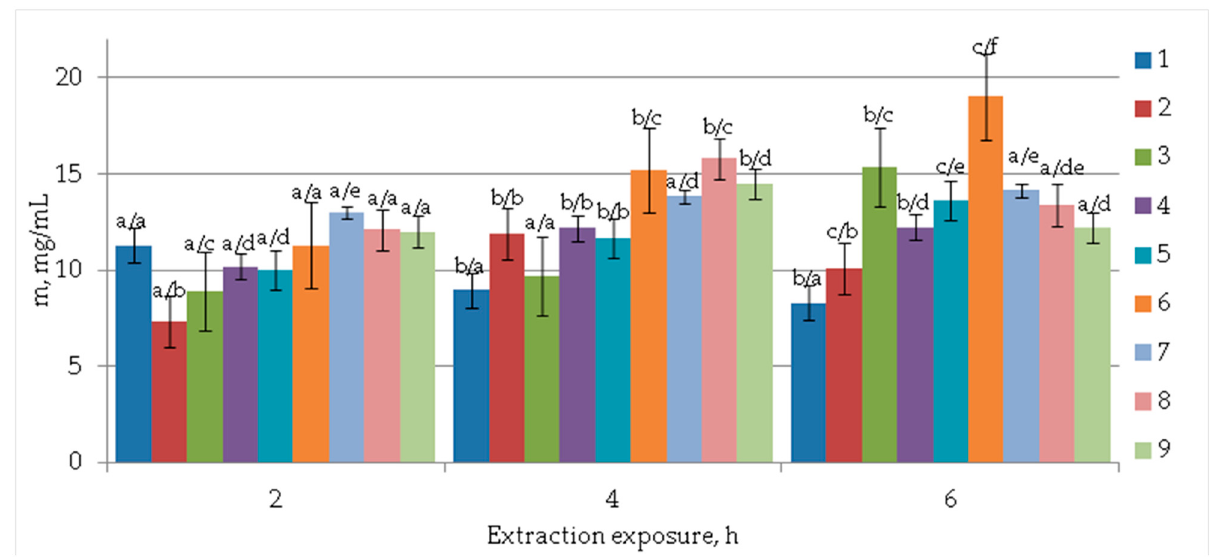
Figure 1. Effect of extractant concentration (C, %), extraction temperature (T, °C), and extraction exposure ( τ , h) on extraction of target flavonoid components in terms of quantitative quercetin content (mg/mL), as follows: 1—T = 30 °C; C = 30%, 2—T = 30 °C; C = 50%, 3—T = 30 °C; C = 70%, 4—T = 50 °C; C = 30%, 5—T = 50 °C; C = 50%, 6—T = 50 °C; C = 70%, 7—T = 70 °C; C = 30%, 8—T = 70 °C; C = 50%, 9—T = 70 °C; C = 70%. Data presented as a mean ±SD ( n = 3). Values followed by the same letter do not differ significantly ( p > 0.05) in extraction dynamics/in different extraction modes.